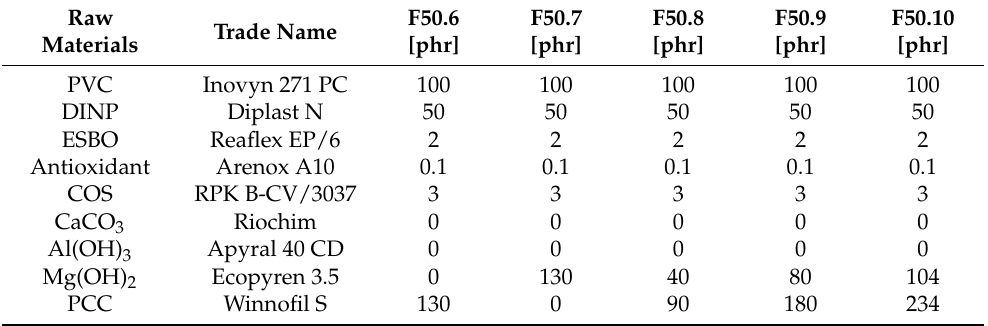
Table 2. Second series of formulations. pH and conductivity are measured according to EN